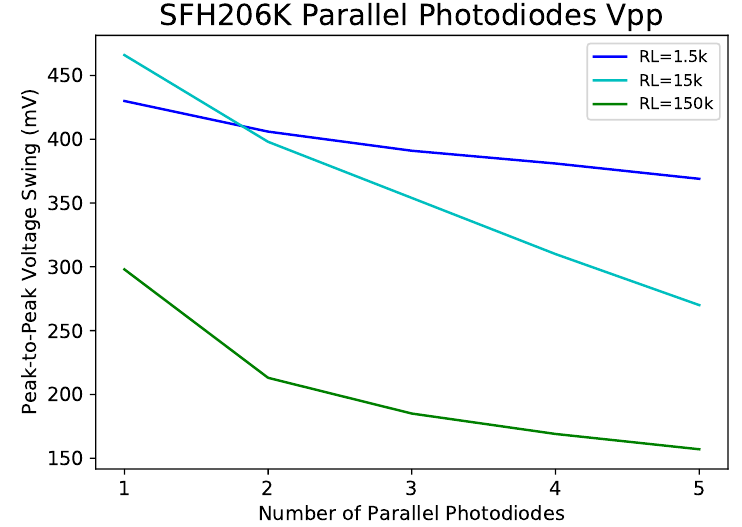
Figure A1. Peak-to-peak voltage swing of an array of parallel SFH206K photodiodes, in which only one of them is illuminated by a 5 mW laser at 2 cm switching at 1 kHz. Adding photodiodes generally increases the parallel capacitance and the fall time. With two or more photodiodes, a lower load resistance (1.5 k Ω ) is necessary to quickly drain the combined parasitic